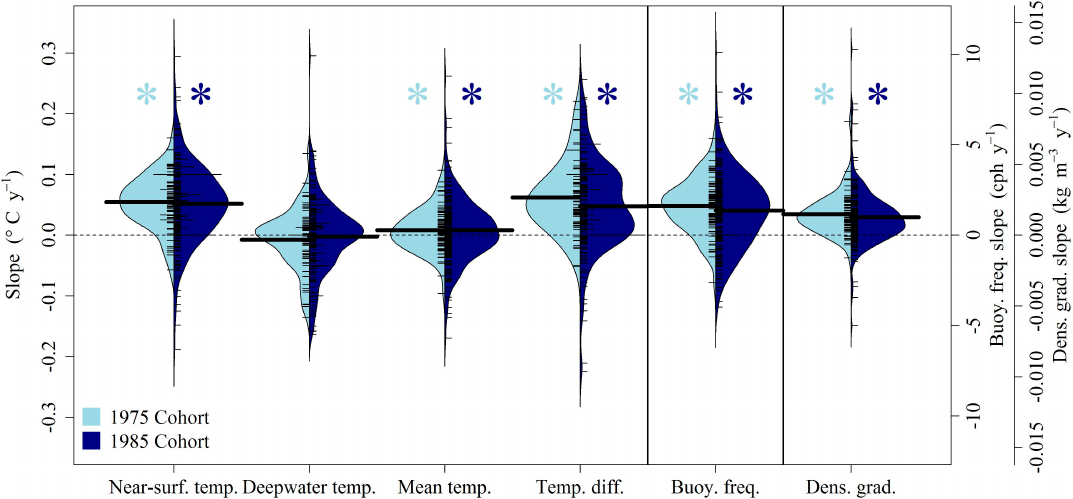
Figure 2. Bean plots showing the magnitude of trends for each metric of lake thermal structure for NENA lakes as follows: Near-surface temperature (Near-surf. temp), Deepwater temperature (Deepwater temp.), mean temperature (Mean temp.), Temperature difference (Temp. diff.), maximum buoyancy frequency (Buoy. freq.), and density gradient (Dens. grad.). For each metric, the left half (light blue) of the bean plot represents the distribution of the 1975 cohort (1975–2014), and the right half (dark blue) represents the distribution of the 1985 cohort (1985–2014). The four metrics of temperature follow the left y -axis (°C y − 1 ); the buoy. freq. follows the first y -axis on the right (cph y − 1 : cycles per hour y − 1 ); and the dens. grad. follows the second y -axis on the right (kg m − 3 y − 1 ). Asterisks indicate a significant difference from zero.